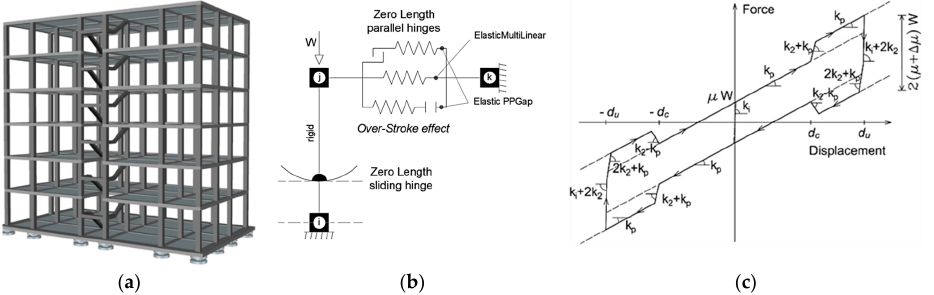
Figure 7. ( a ) Schematical representation of the base-isolated prototype building. DCCSS isolators: ( b ) numerical models and ( c ) constitutive law. The finite element friction-pendulum isolator (SingleFPBearing) was used for the DCCSS isolator modelling in numerical nonlinear analyses. The cyclic nonlinear behav-